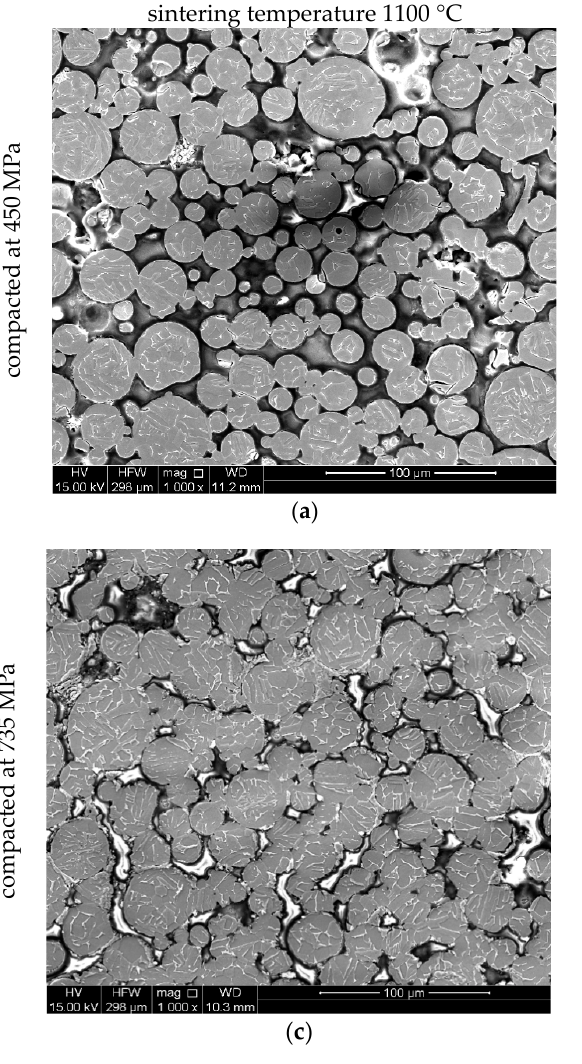
Figure 4. SEM micrographs of etched ( a ) starting powder particles and ( b ) L-PBF sample.